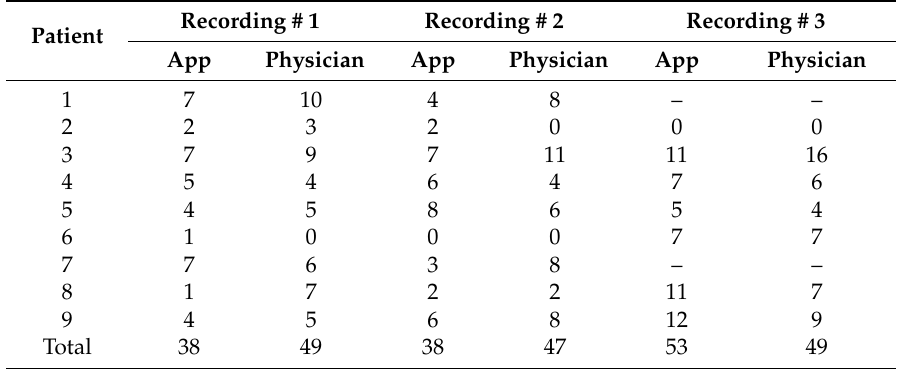
Table 4. Crackle detection results in recordings from DIP patients ( N = 9) using the automated detector implemented in the app and by a